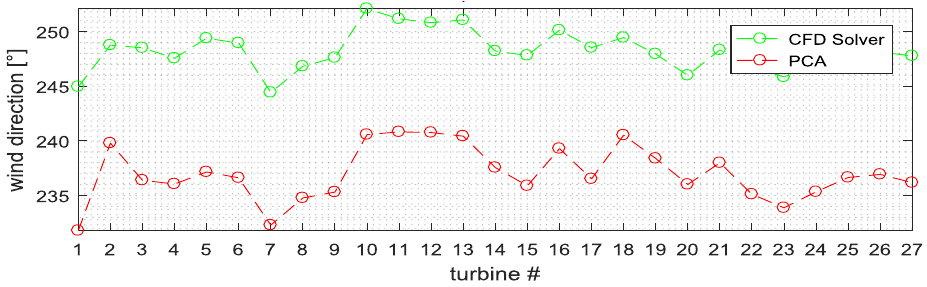
Figure 8. Comparison between spatial power output obtained from CFD solver output (green) and obtained by using of PCA for the 2nd forecasting hour.